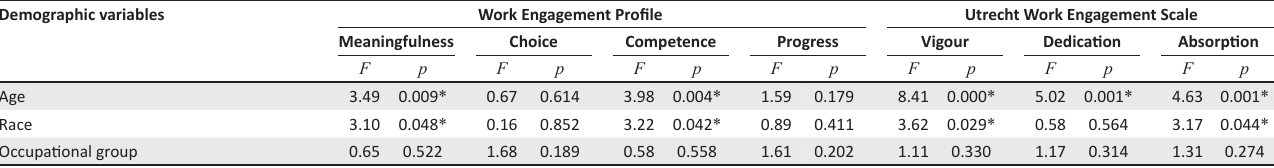
TABLE 4: Work Engagement Profile and Utrecht Work Engagement Scale factors according to demographic variables. Demographic variables Work Engagement